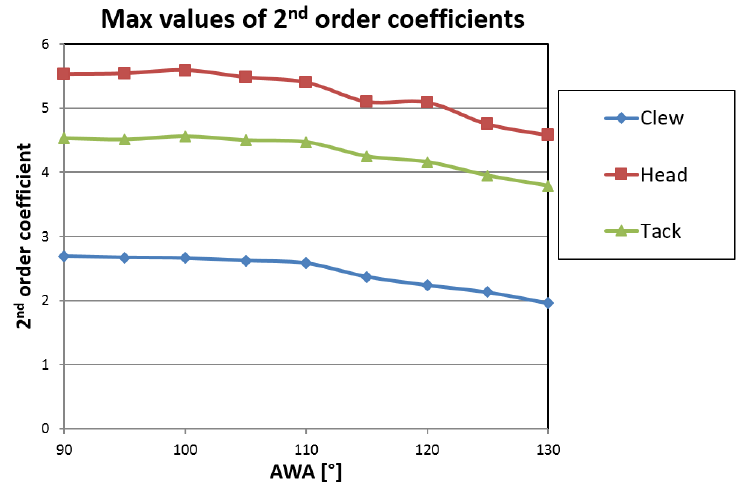
Figure 19. Plots of maximum value of second order coefficients vs. AWA.